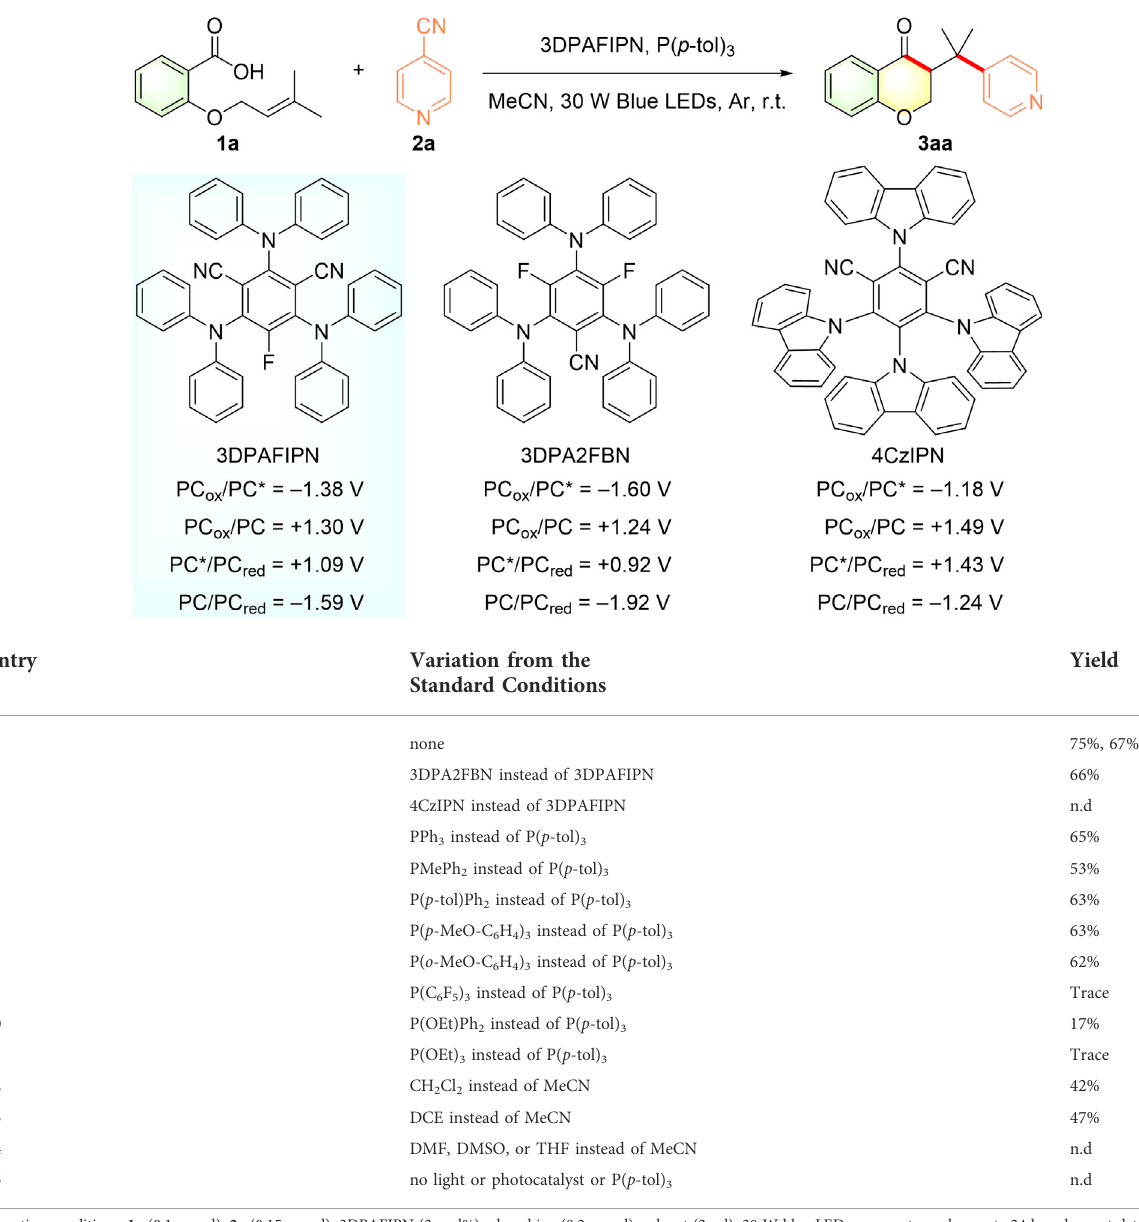
TABLE 1 Optimization of the reaction conditions a,b